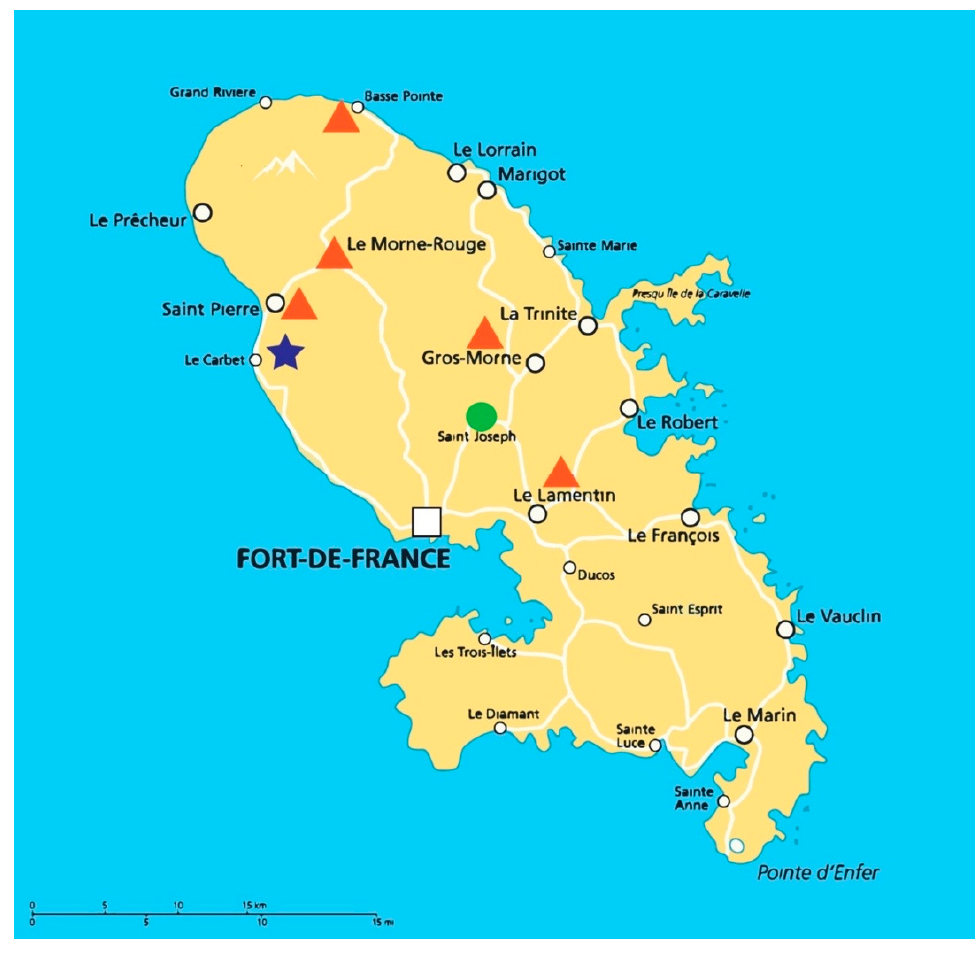
Figure 1. Geographical localization of soil samplings. The orange triangles represent the localization of banana plantations, the blue star, the sugar cane field and the green circle, the natural forest.